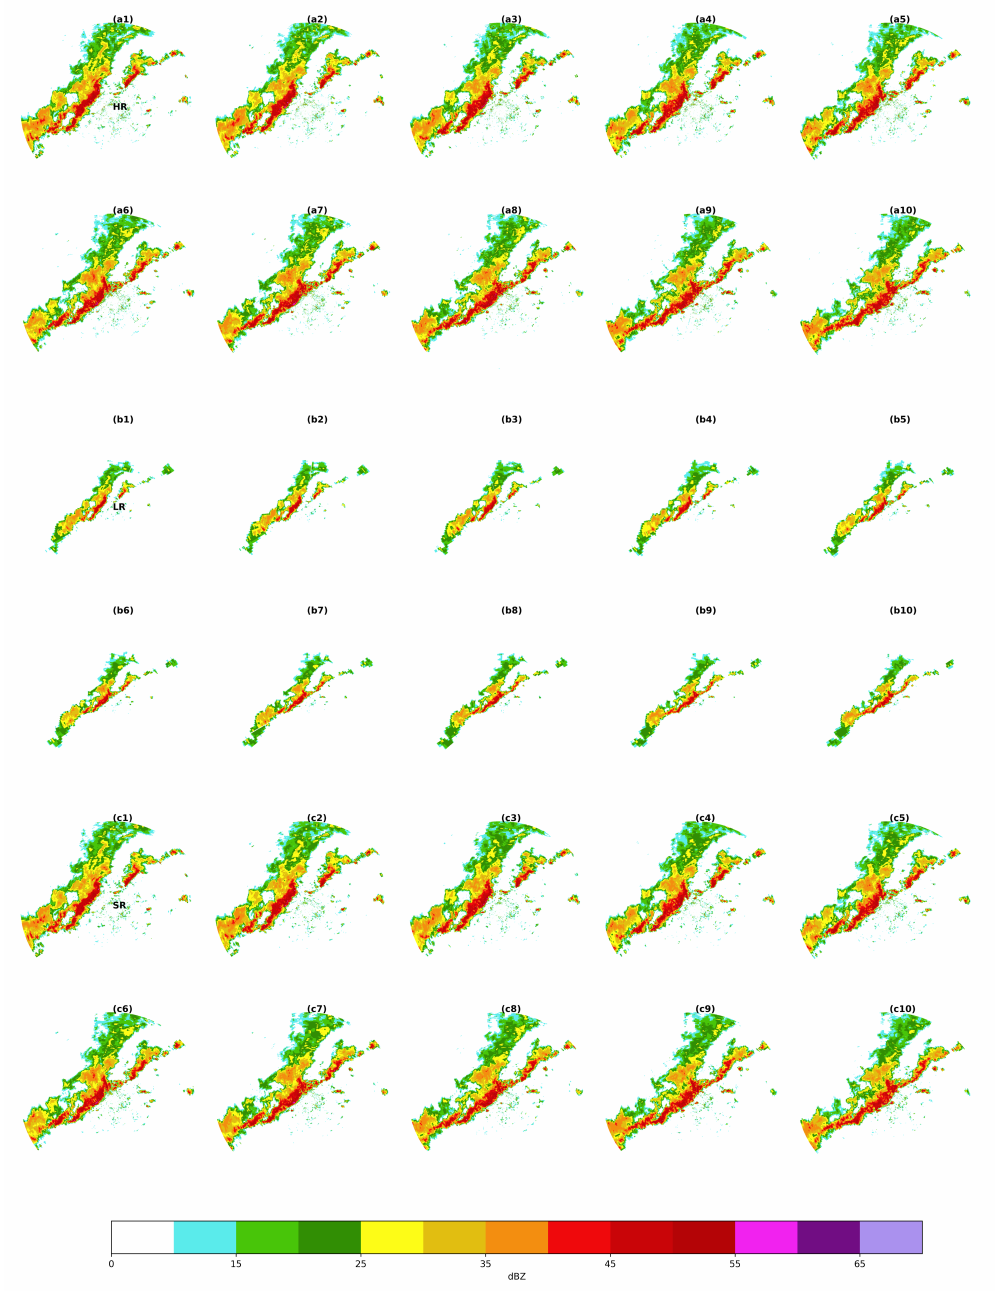
Figure A1. Precipitation data on the scaling factor ×